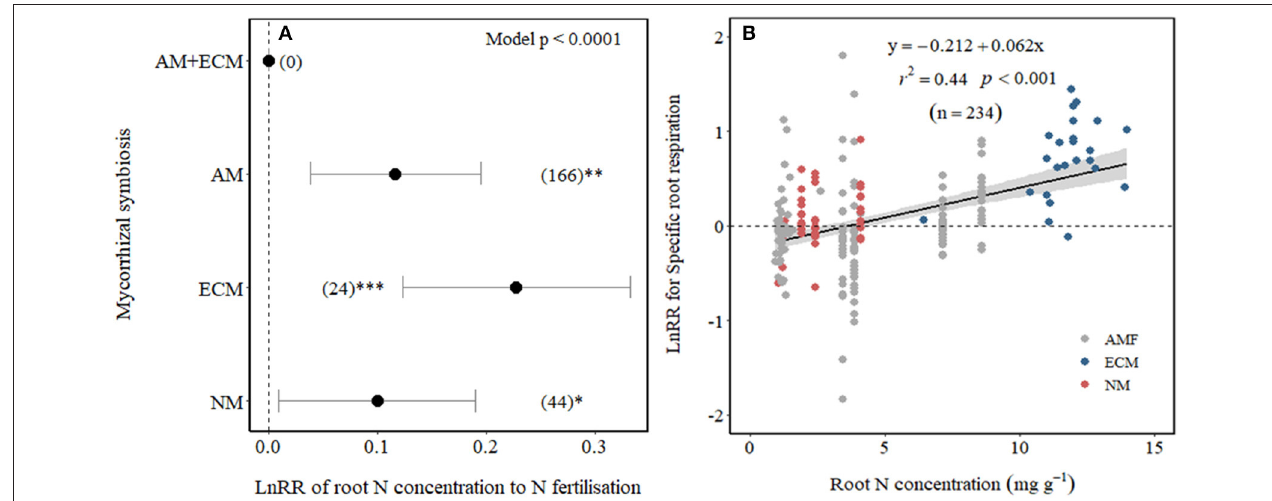
FIGURE 4 | Effect sizes (LnRR) of root N concentration to N fertilisation (A) in association with different mycorrhizal symbiosis and (B) meta-regression relating LnRR of SRR to N fertilisation with root N concentration in fertilised treatments (NM, non-mycorrhizal—red symbols; ECM, ectomycorrhizal—blue symbols; and AM, arbuscular mycorrhizal—grey symbols). ***, **, and *indicate significance at p < 0.0001, p < 0.01, and p < 0.05, respectively. Shade band around the regression fit represents 95% CIs. Only observations from field experiments are